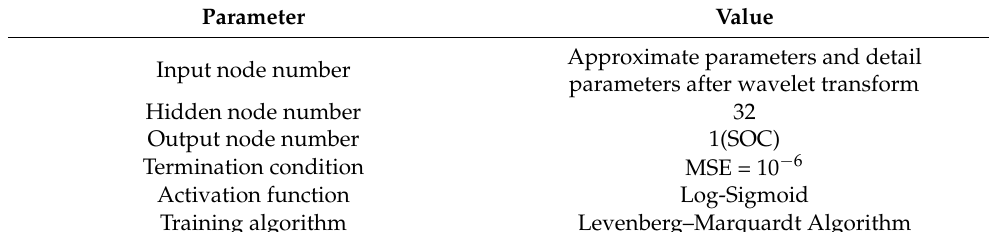
Table 2. Training parameters of the neural network.